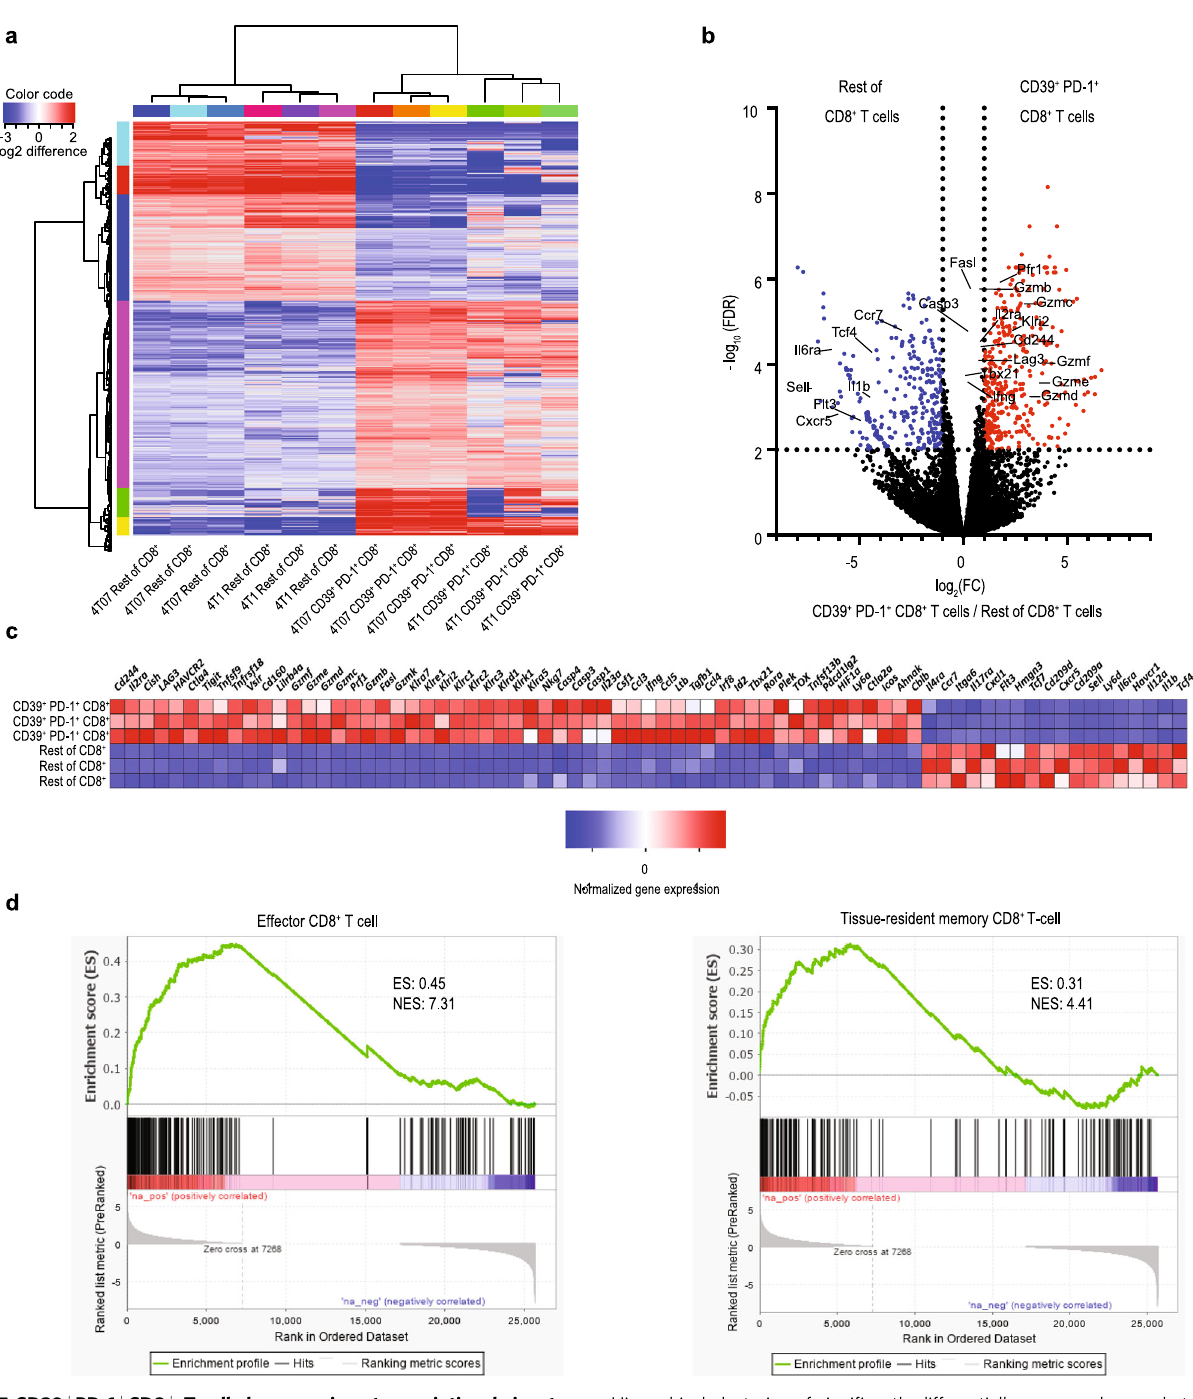
Fig. 5 CD39 + PD-1 + CD8 + T cells have a unique transcriptional signature. a Hierarchical clustering of signi fi cantly differentially expressed genes between sorted CD44 + CD39 + PD-1 + CD8 + and CD44 + CD8 + T cells. b Volcano plot comparing transcripts in CD44 + CD39 + PD-1 + CD8 + T cells with those in other CD44 + CD8 + T cells sorted from 4T07 breast tumors. The red symbols represent transcripts that are signi fi cantly over-expressed in CD44 + CD39 + PD-1 + CD8 + T cells, whereas the blue symbols represent signi fi cantly under-expressed transcripts. c Heat map showing relative expression of selected transcripts in CD44 + CD39 + PD-1 + CD8 + (three top rows) and other CD44 + CD8 + T cells (three bottom rows) identi fi ed by differential gene expression analysis. d Gene set enrichment analysis comparing the transcriptional pro fi le to the data published by Goldrath et al. 80 (left panel) and Savas et al. 19 (right panel).